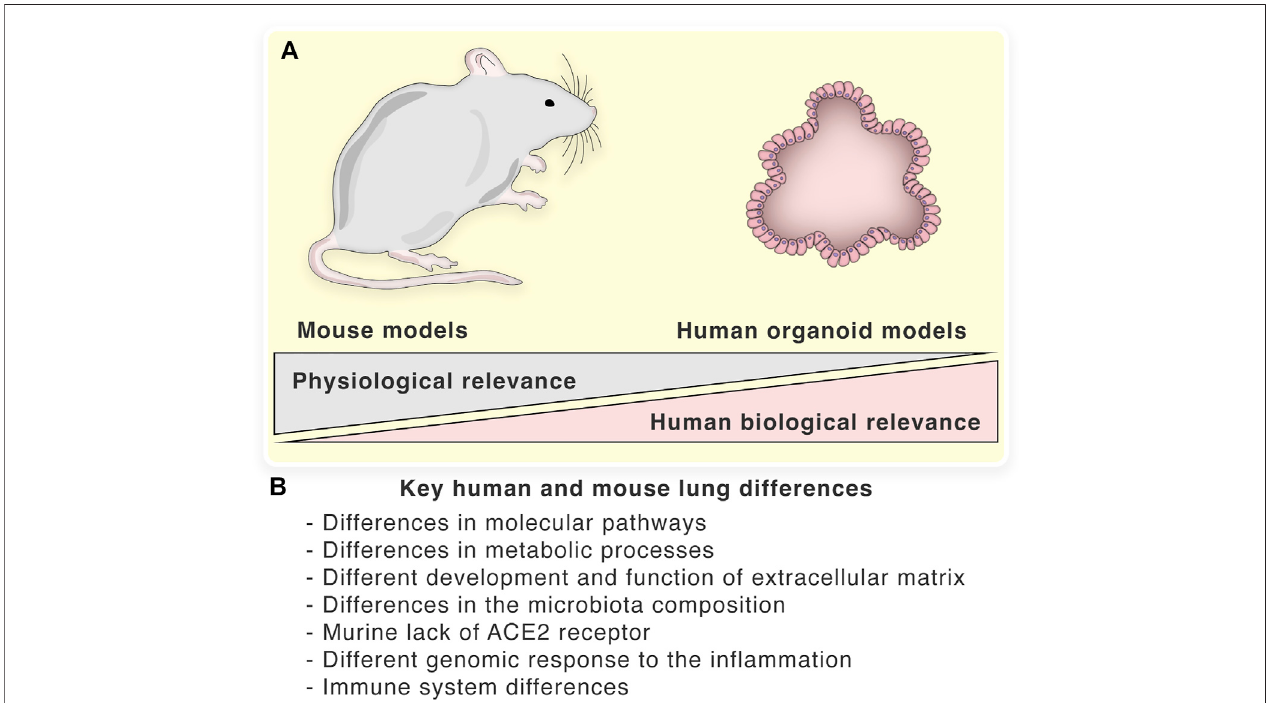
FIGURE 1 | Key human and mouse lung differences: (A) — Biological and physiological relevance of mouse and organoid models. (B) — The main differences between human and mouse lungs.